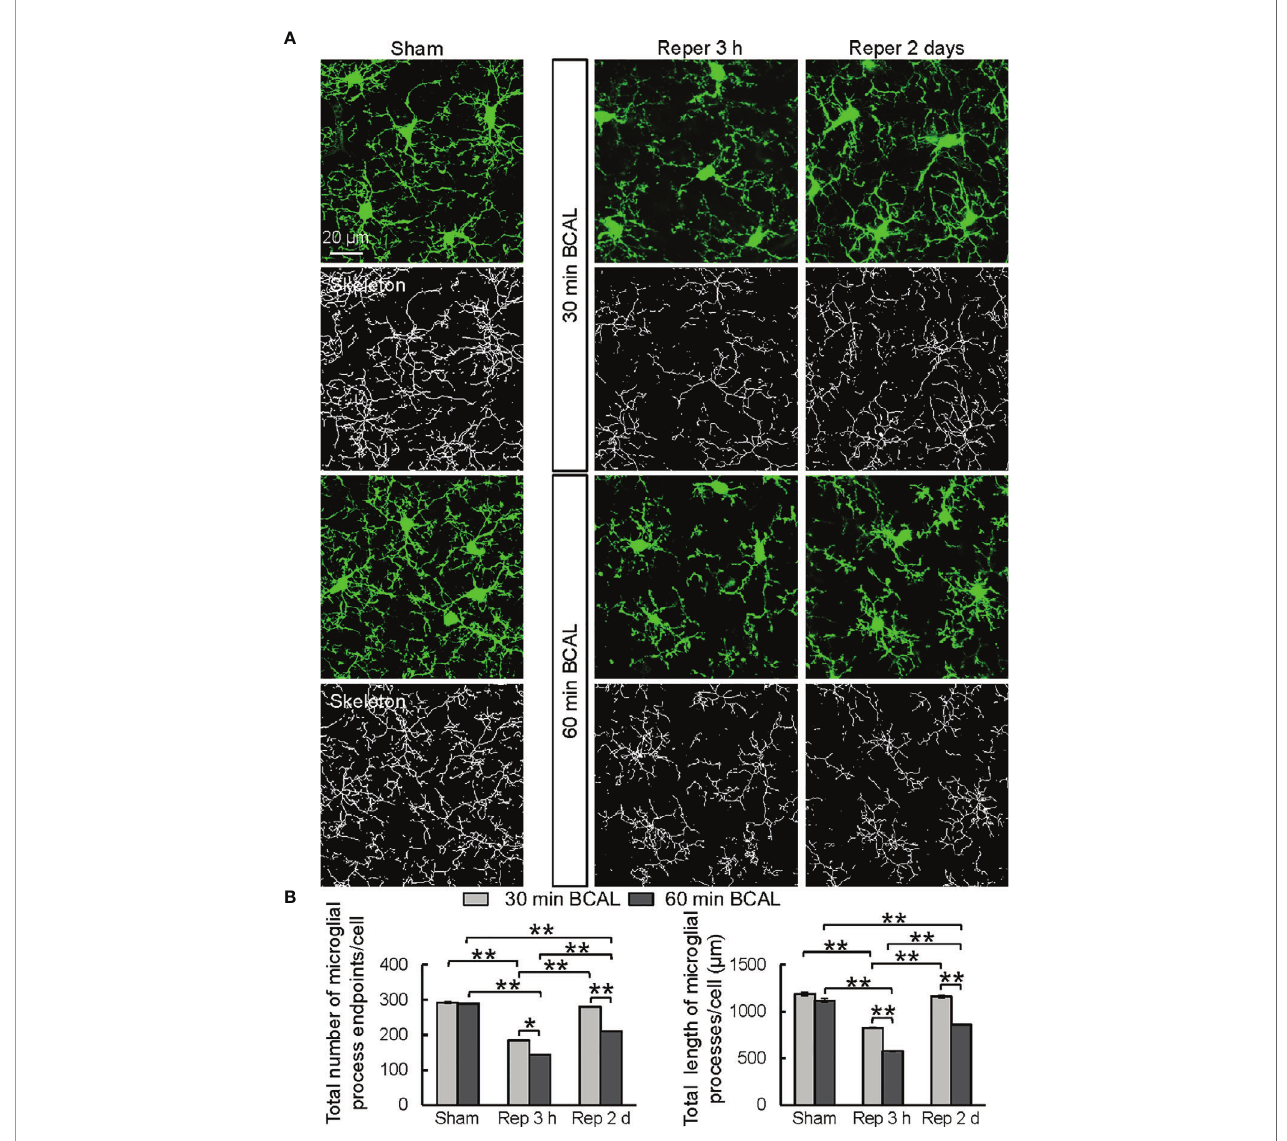
FIGURE 2 | Microglial morphology is differentially regulated by the degree of ischemia. (A) Representative confocal images showing morphologies of microglia (green) and skeletonized microglia in Sham group, and at 3 h, 2 days after ischemia in 30 min BCAL group and 60 min BCAL group. (B) Quanti fi cation of total number of microglial process endpoints and total length of microglial processes per cell. Note that both 30 and 60 minutes of ischemia have decreased number of microglial process endpoints and length of microglial processes. There is no signi fi cant difference in the total number of microglial process endpoints and the total length of microglial processes of each cell between 30 min BCAL group and Sham group, but there are signi fi cant reductions in 60 min BCAL group compared to Sham group. (n = 50 microglia from 5 mice for each group; * p <0.05, ** p